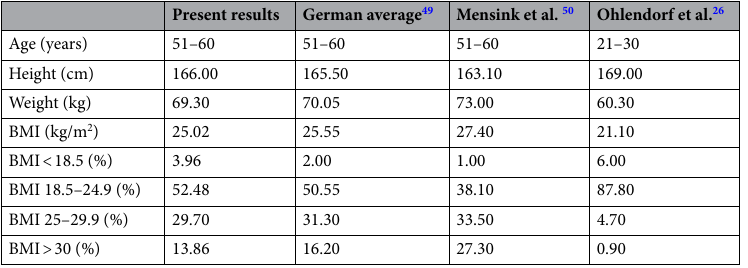
Table 2. Comparison of anthropometric parameters between the present results and other